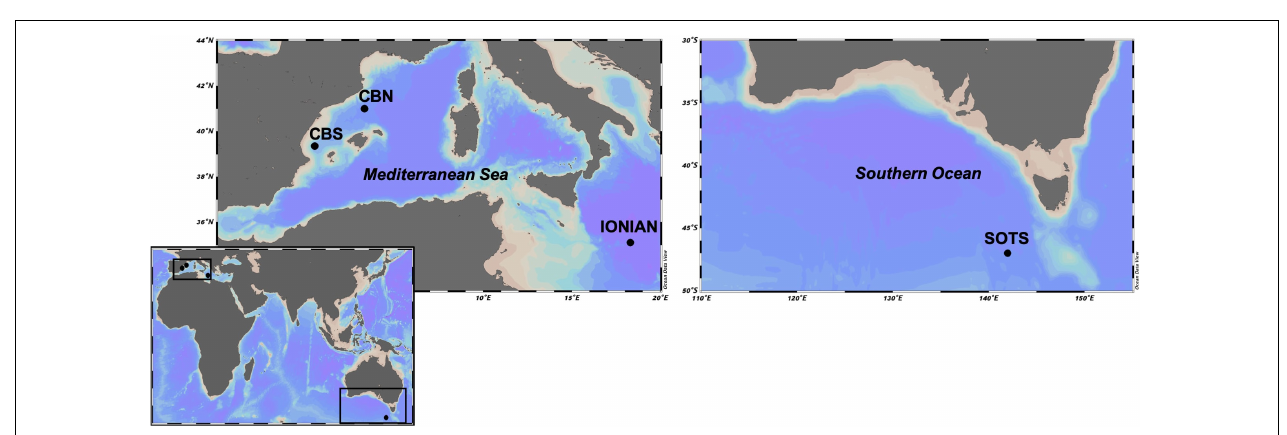
FIGURE 2 | Study areas where duplicate ocean depth-profiles were collected for total 210 Pb and 210 Po analyses in the Catalano-Balear (north: CBN; south: CBS) and Ionian Seas (left map), and at the Southern Ocean Time Series (SOTS) site (right map).